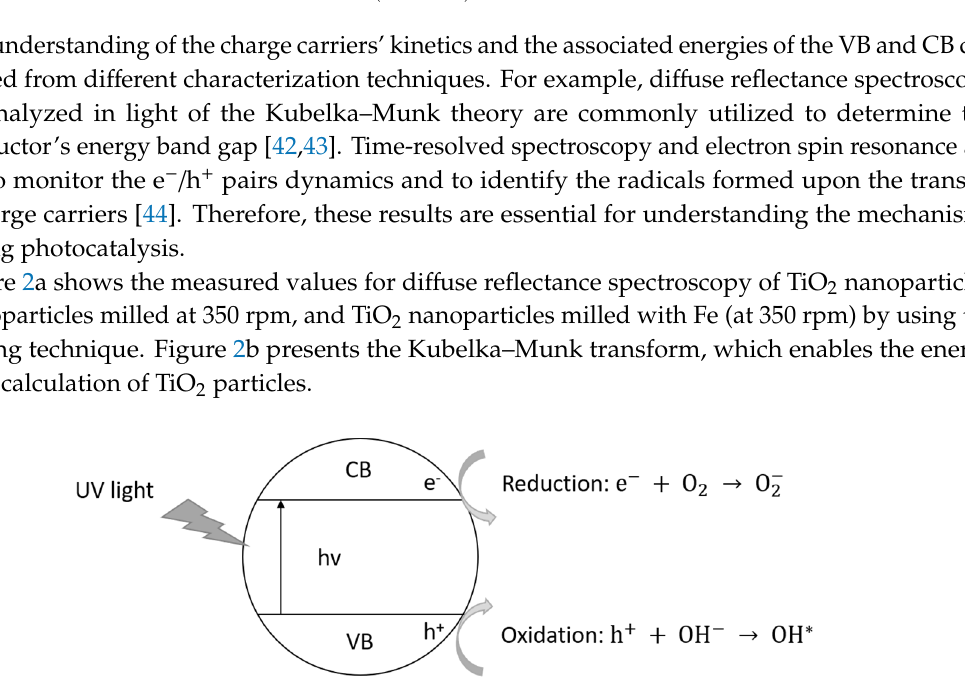
Figure 1. Schematic representation of the photo-excitation in a semiconductor material. Adapted with permission from [35]. Copyright 2003 Elsevier.